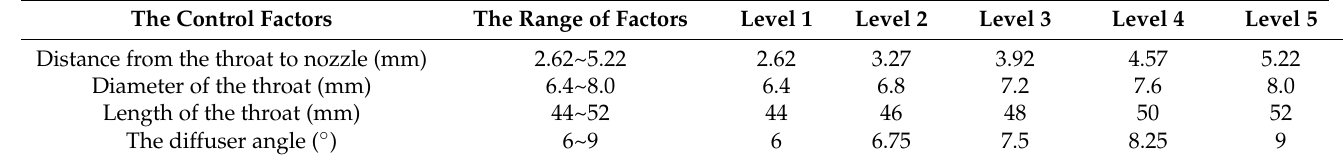
Table 9. The range and level design of control factors.